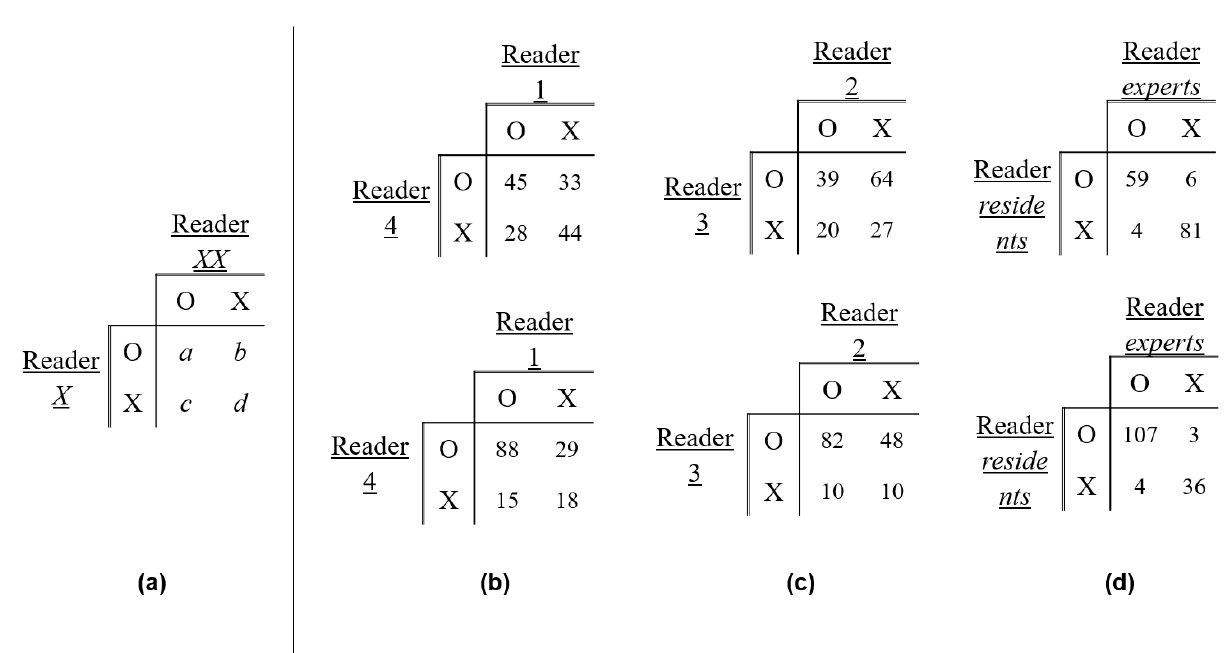
Figure 5. ( a ) An example confusion matrix for identifying real images ( b ) between two expert radiologists; top: priority-first, bottom: priority-first + second, ( c ) between two residents; top: priority-first, bottom: priority-first + second, and ( d ) between experts and resident radiologists; top: priority-first, bottom: priority-first + second.